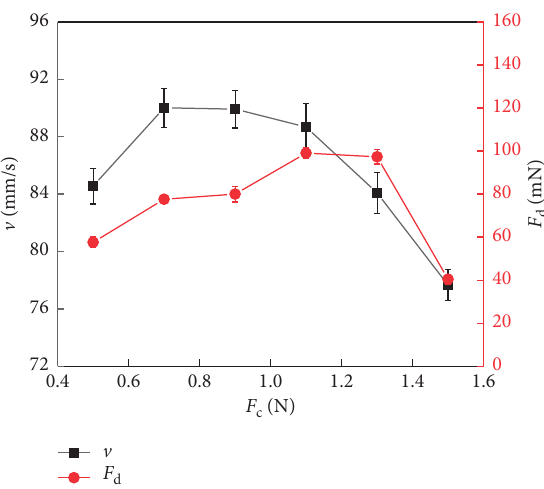
Figure 15: Variation of stall force and average velocity with preload F